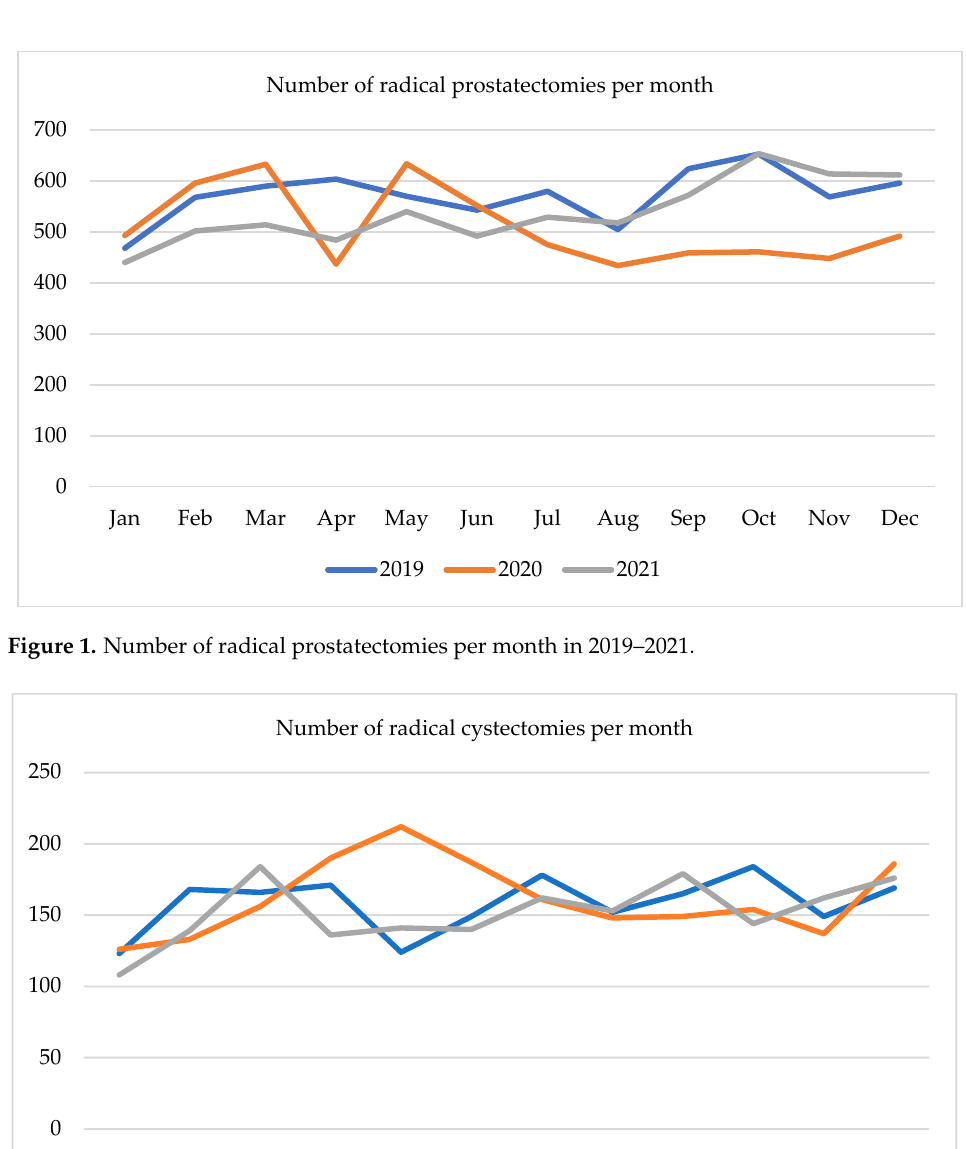
Figure 1. Number of radical prostatectomies per month in 2019–2021.